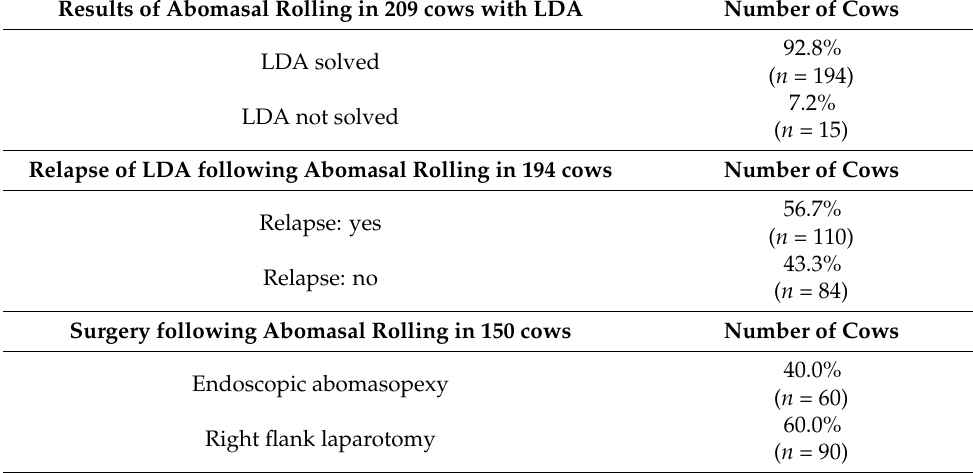
Table 3. Results of conservative treatment of left displacement of the abomasum (LDA) in 209 cattle (31.1% of patient population). Conservative treatment consisted of abomasal rolling by means of a tilt table at the Clinic for Ruminants with Ambulatory and Herd Health Services. In 3 cows, information about abomasal rolling (“yes” or “no”) was not given in the medical files; therefore, these were excluded from the statistical model. After abomasal rolling, LDA was solved in significantly ( p < 0.01) more cows compared with not solved. A total of 71.8% ( n = 150) of cows were submitted to surgery following abomasal